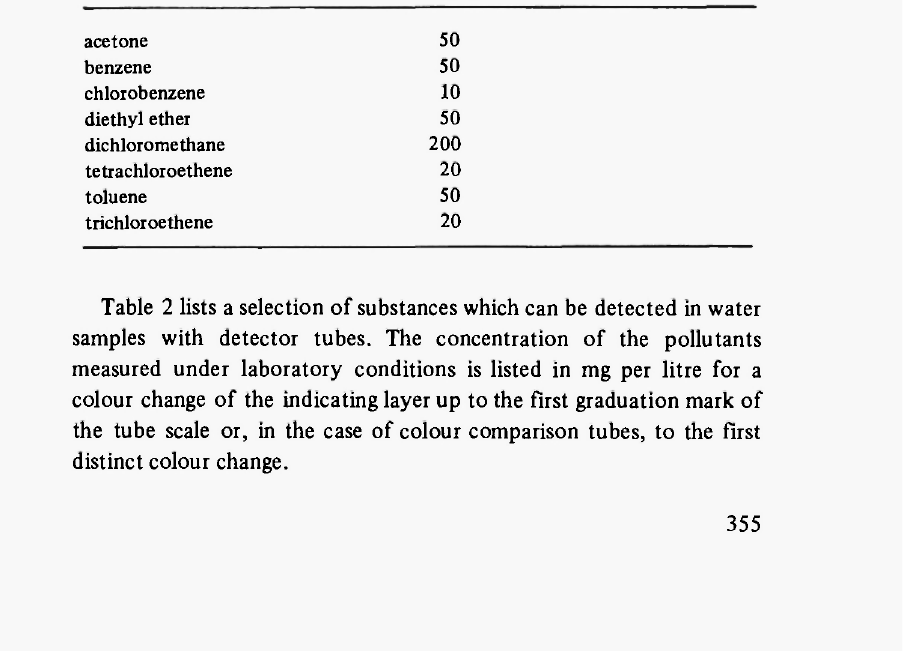
TABLE 1: POLLUTED SOIL